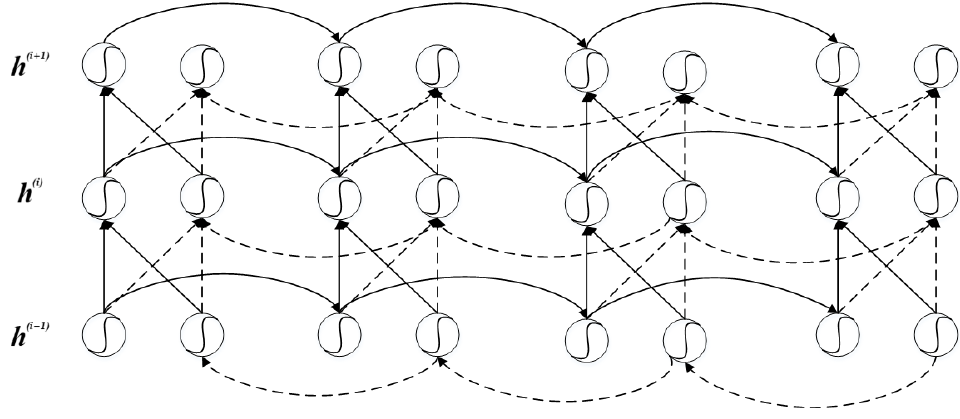
Figure 5. Bi-GRU structure.